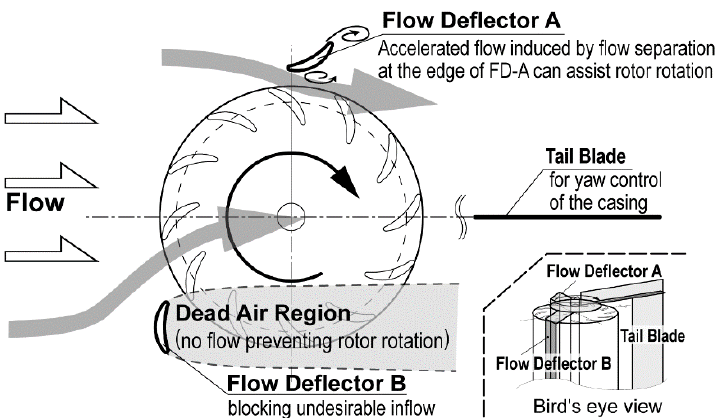
Figure 1. Schematic illustration of the flow of cross-flow wind turbine with wind-collecting casing with two flow deflectors.